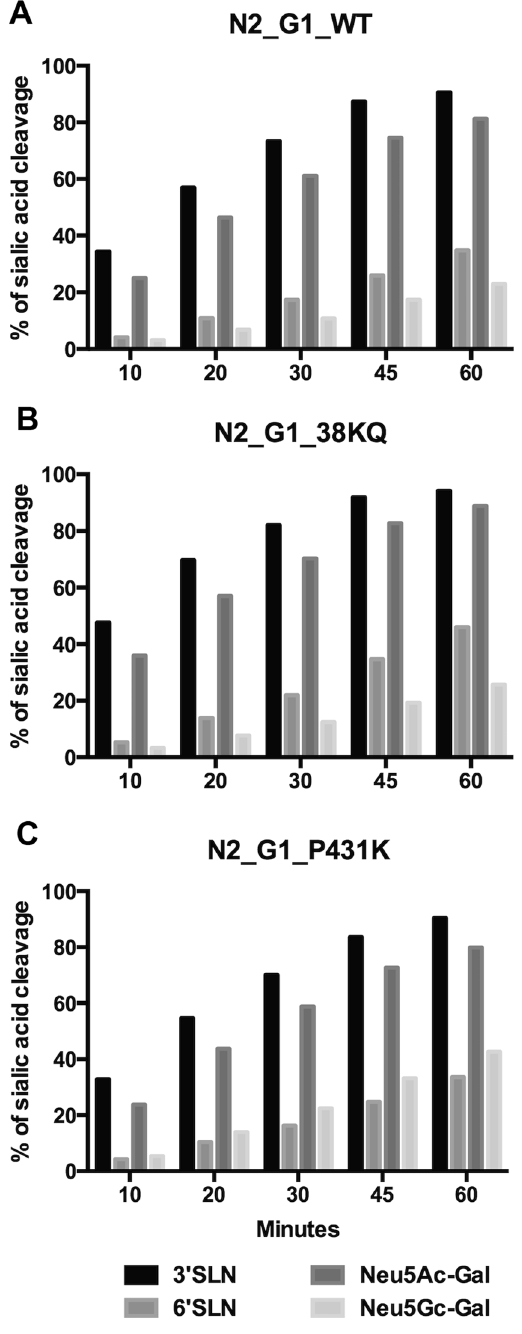
Figure 5. Cleavage of glycans by influenza neuraminidase. Cleavage of different sialylated glycans 3-sialylolactosamine (3-SLN), 6-sialylolactosamine (6-SLN), Neu5Ac-Galactose (Neu5Ac-Gal) and Neu5Gc- Gal by ( A ) H9N2 GI, ( B ) H9N2 with replacement of the two amino acid stalk deletion and ( C ) H9N2 with mutation of